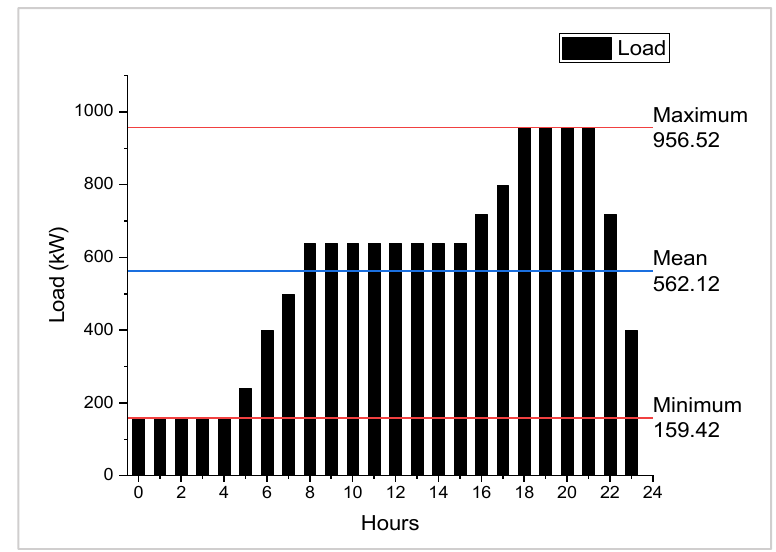
Figure 5. Annual average hourly load profile of the Nazira oil and gas field.